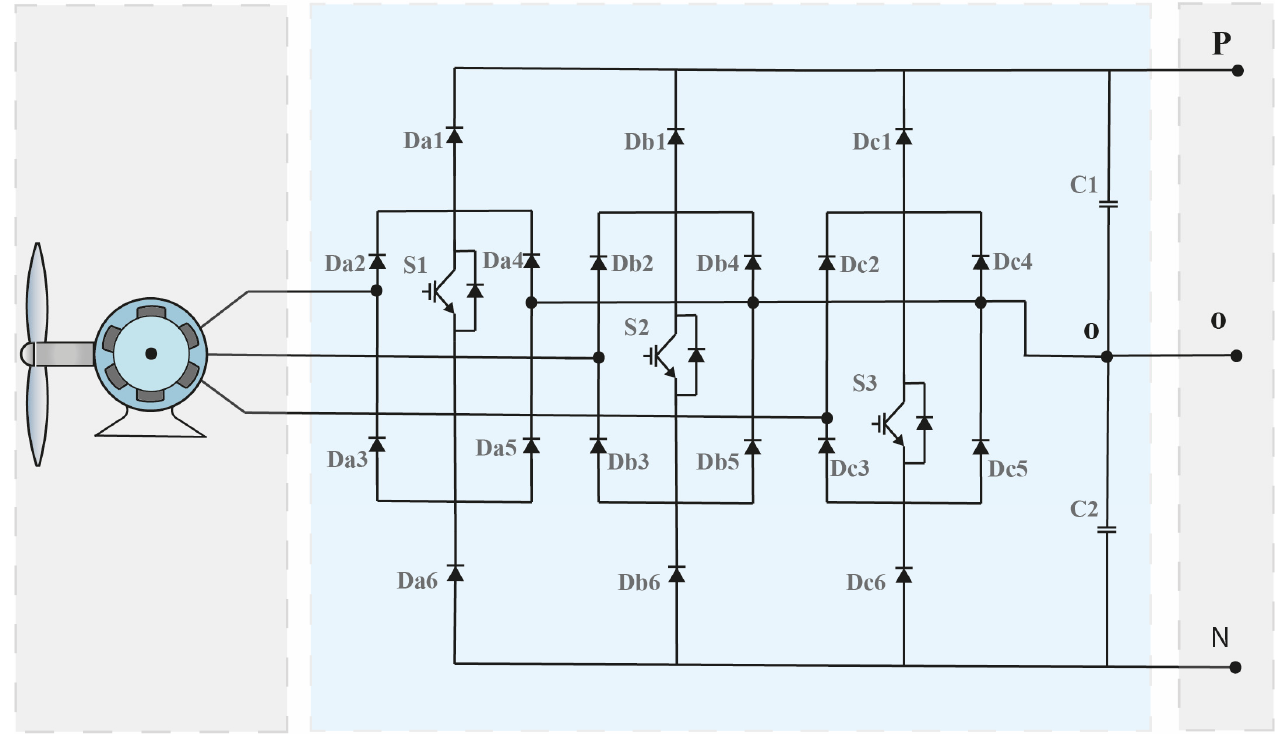
Figure 2. Vienna rectifier based on PMSG wind turbine applications.